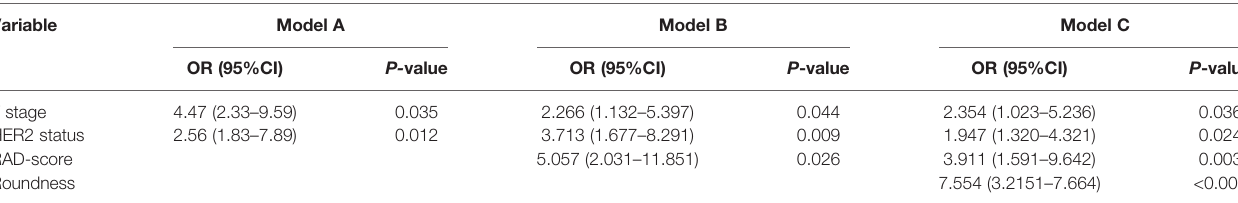
FIGURE 4 | Selection of radiomics features via LASSO algorithm to establish a RAD-score. (A) Tuning parameter selection by 10-fold cross-validation with minimum criteria. Mean square error (y-axis) was plotted as a function of log(lambda) (x-axis). (B) LASSO coef fi cient pro fi les for the whole features. (C) 12 radiomics features corresponding to the selected optimal values for establishment of a RAD-score. LASSO, least absolute shrinkage and selection operator; RAD-score, radiomics score. TABLE 2 | Multivariate logistic